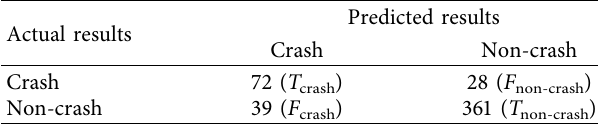
Table 3: Te confusion matrix of single prediction